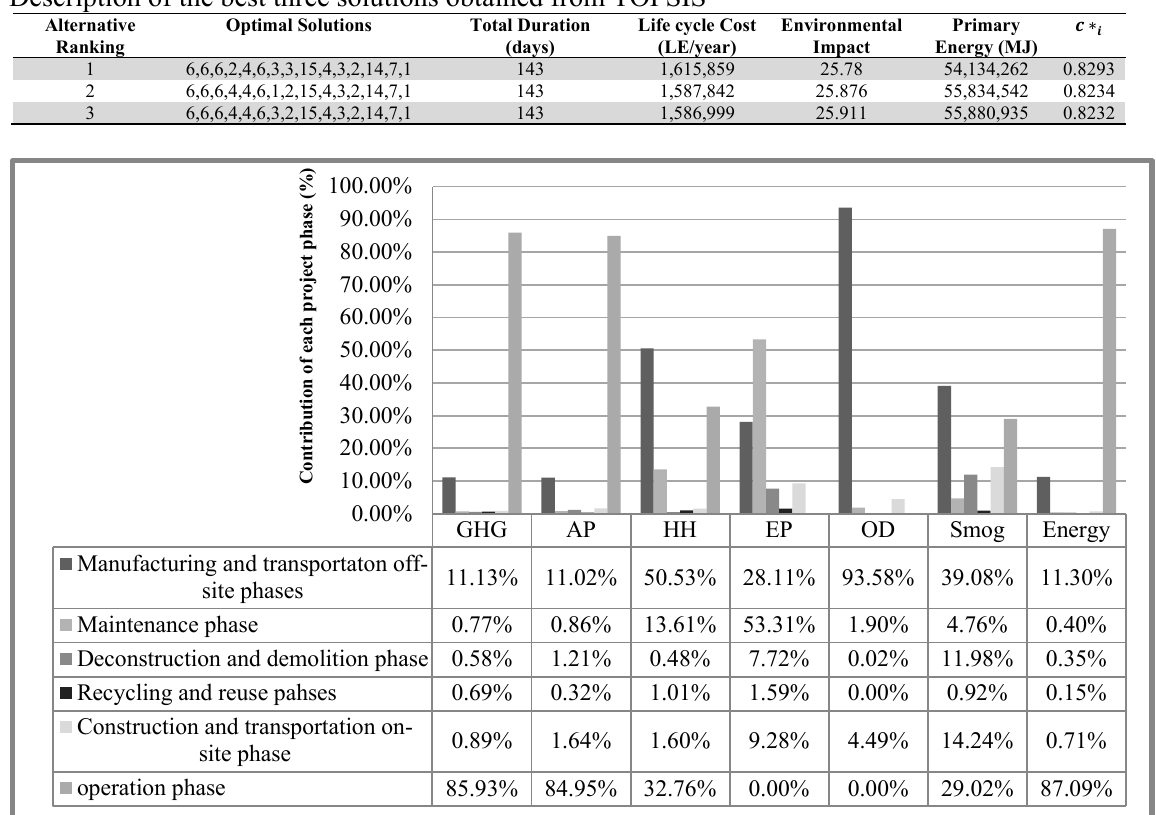
Fig. 12. Contribution of project life cycle phases in producing different environmental emissions and primary